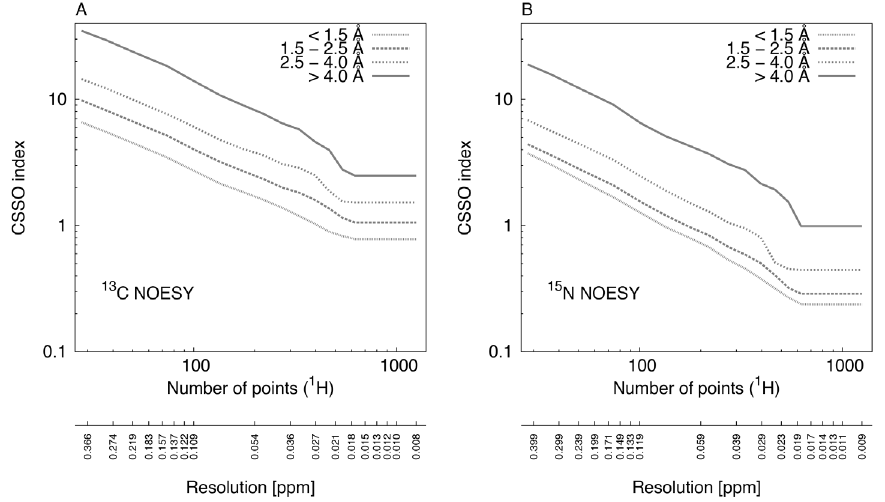
Figure 4. Chemical shift spectral overlap (CSSO) indices as a function of the digital resolution. (A) 13 C-resolved NOESY peak lists. The fine dotted line shows the average CSSO index for 149 protein structures with heavy atom RMSD to the reference structure below 1.5 A˚ calculated at the highest digital resolution (obtained by sampling 1250 points). Dashed, dotted, and solid lines correspond to 210, 14, and 4 protein structures with RMSD values of 1.5–2.5, 2.5–4.0, and more than 4.0 A˚, respectively. (B) Same data for 15 N-resolved NOESY peak